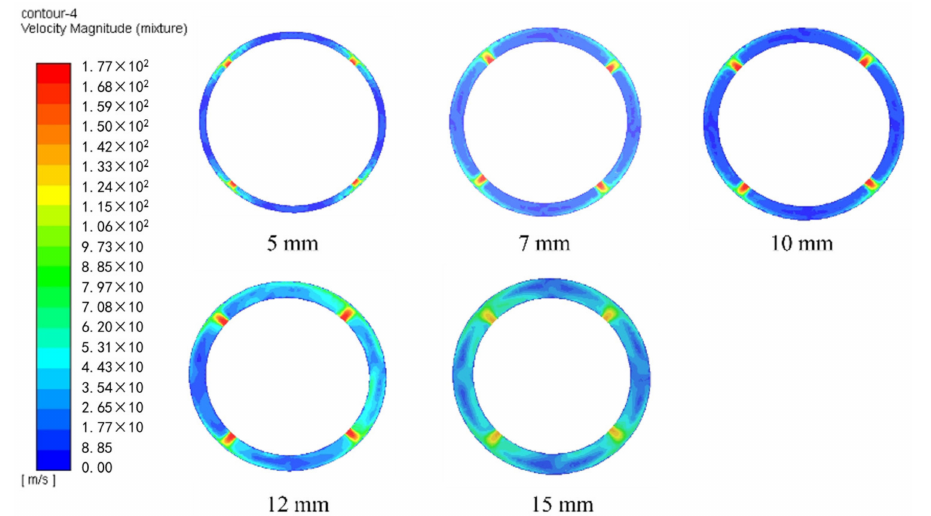
Figure 17. Velocity distribution of rotary jets at different spray